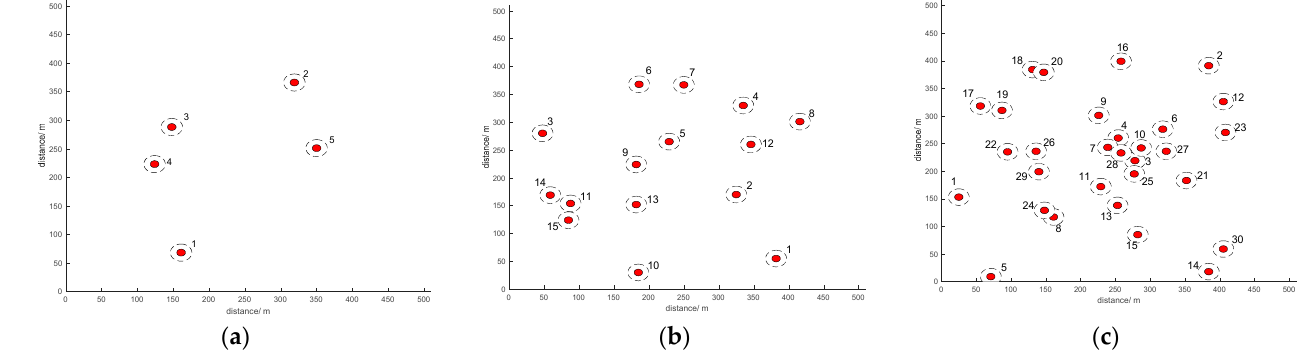
Figure 8. Initial positions of vehicles in MUVs with different numbers of vehicles. ( a – c ) represent initial positions for 5, 15, and 30 vehicles, respectively.